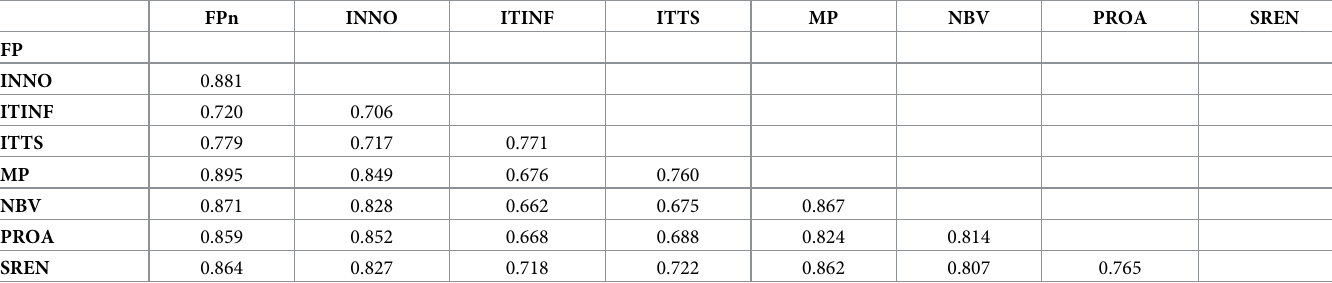
Table 5. Heterotrait-Monotrait (HTMT)